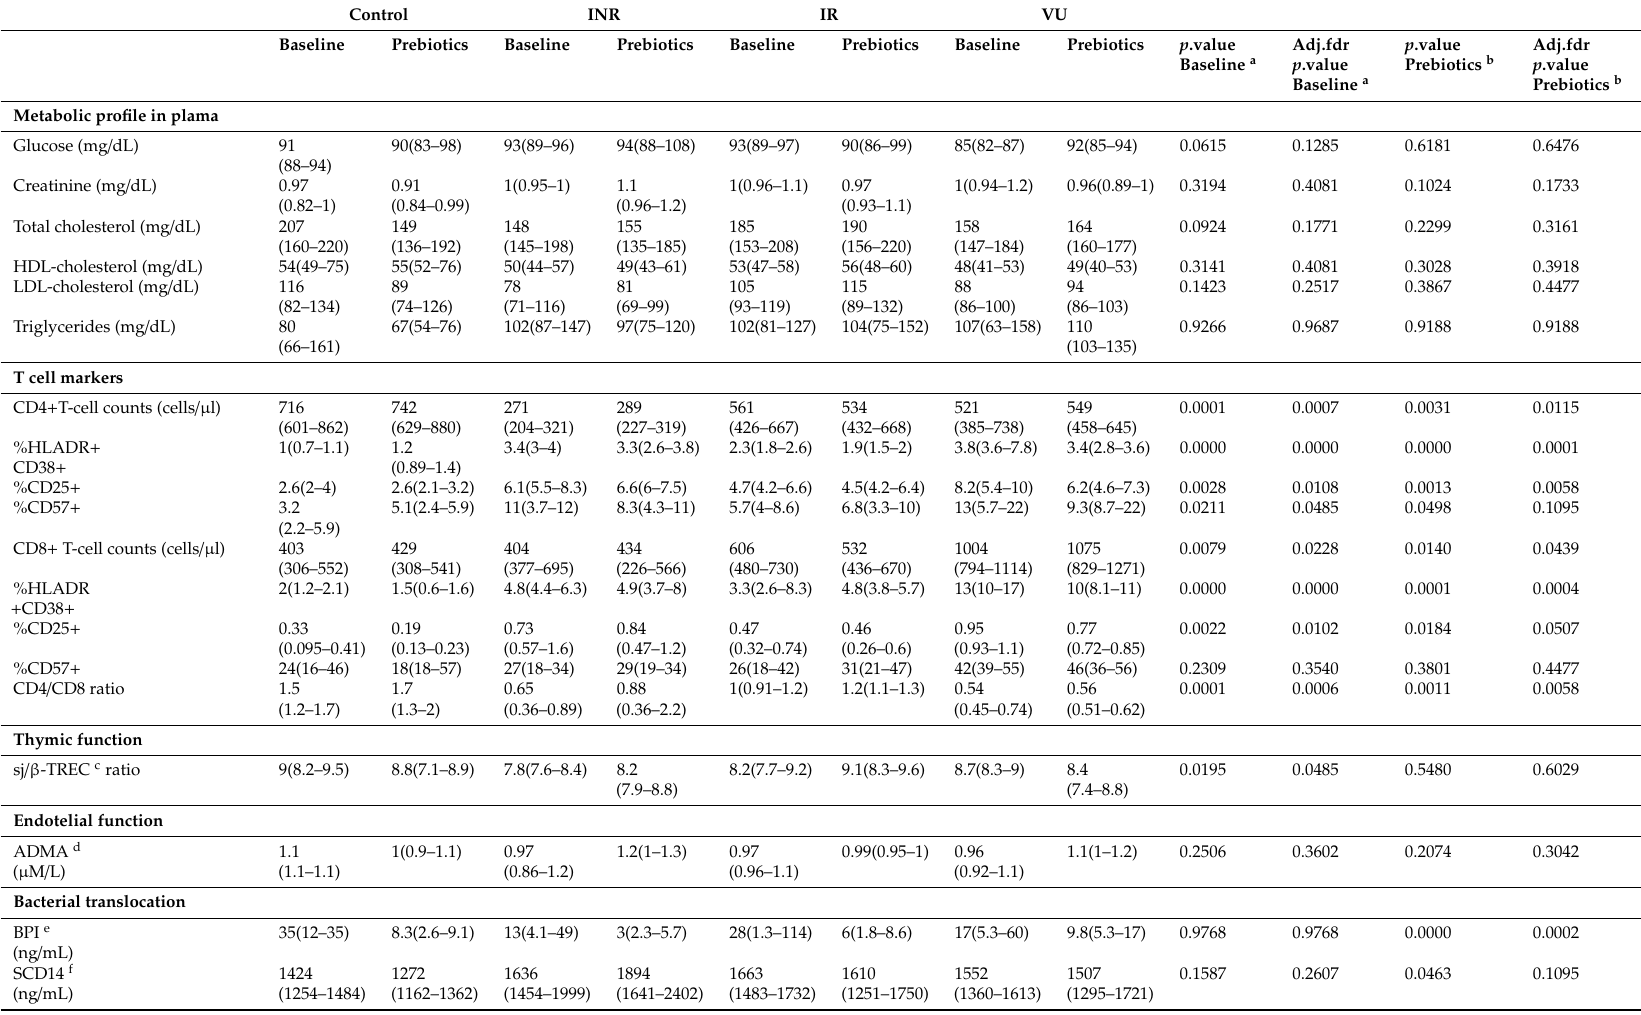
Table 2. Clinical variables at baseline and after prebiotic intervention in studied